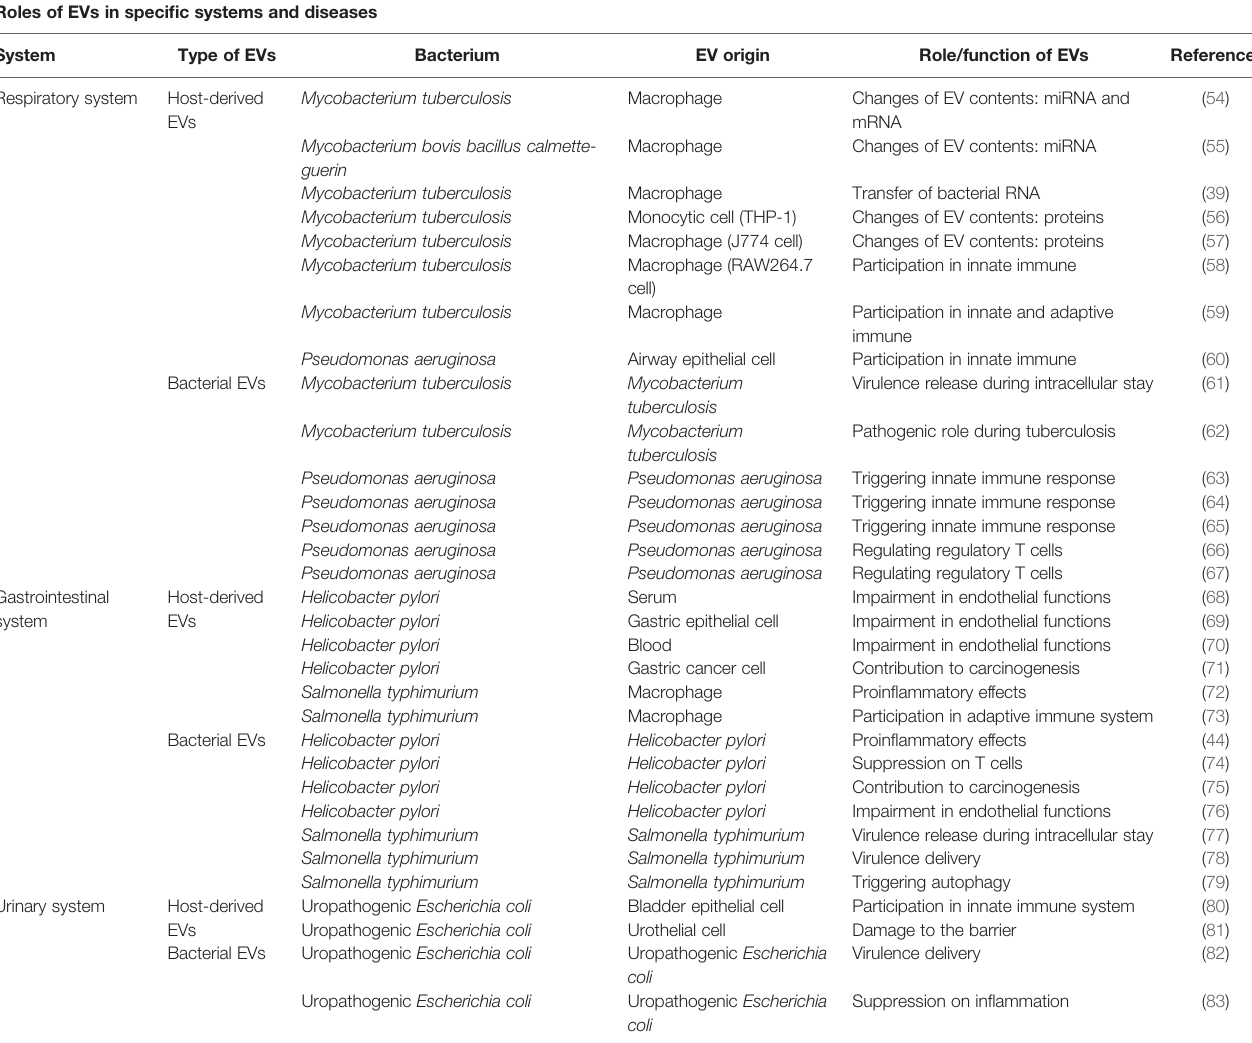
TABLE 1 | Roles of EVs in speci fi c systems and diseases. Roles of EVs in speci fi c systems and